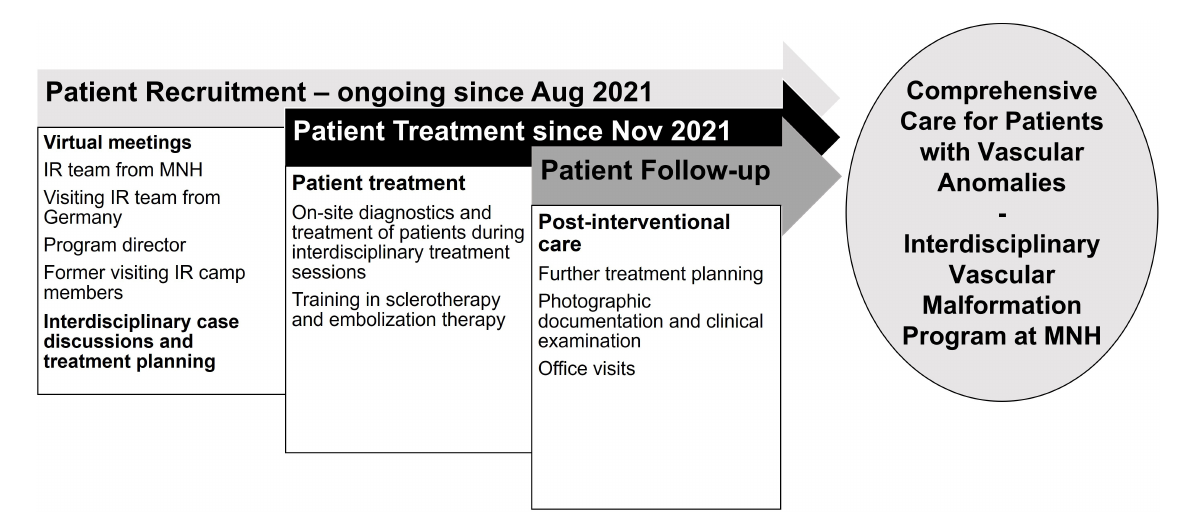
FIGURE1 Timeline of the establishment of a vascular anomalies treatment program in Tanzania: preparation for the two-week camp, goals during hands-on training, and post-interventional patient care. IR = Interventional Radiology; MNH = Muhimbili National